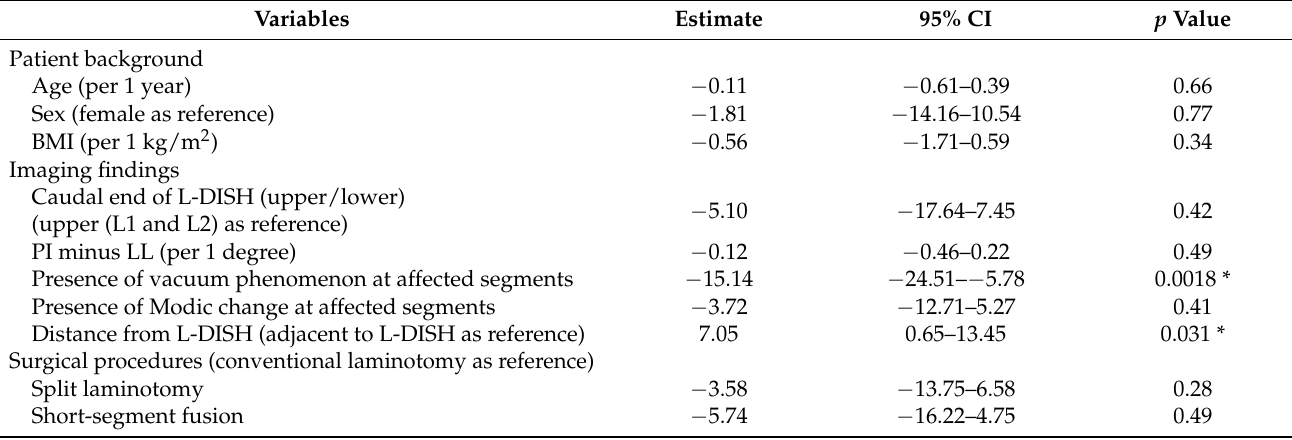
Table 4. Multivariate linear regression analysis of the JOA score improvement rate.